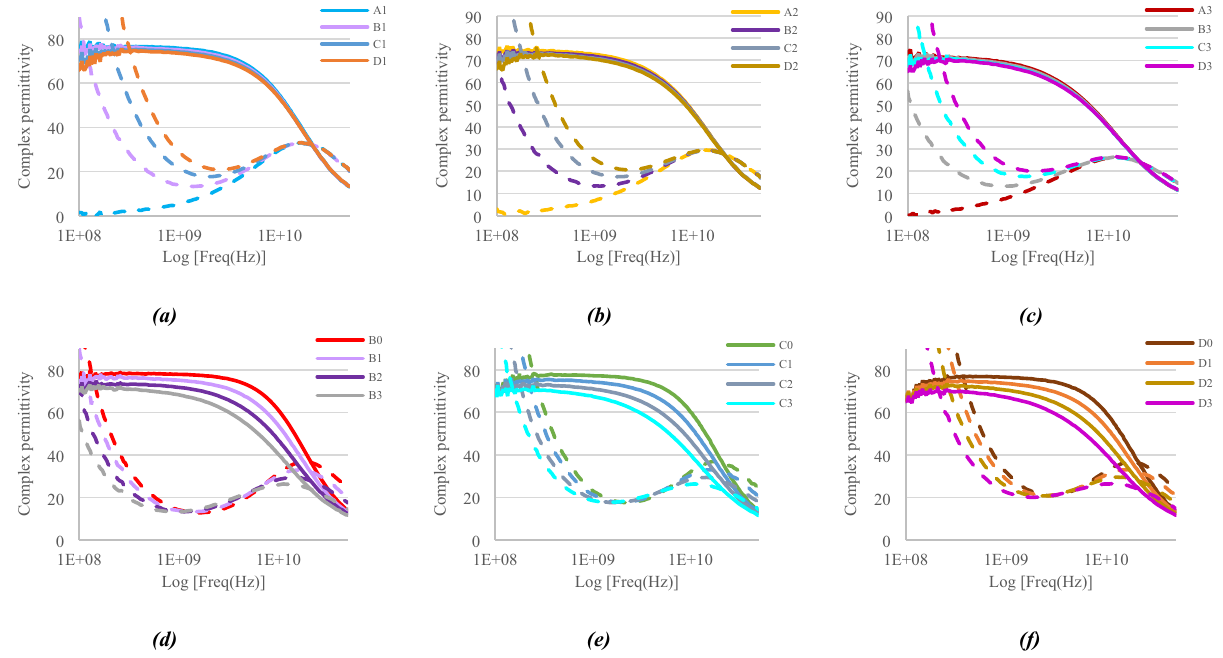
Figure 4. Complex permittivity of samples for given sucrose concentrations ( a–c ) and for given sodium chloride concentration ( d–f ) as a function of frequency (logarithmic scale).